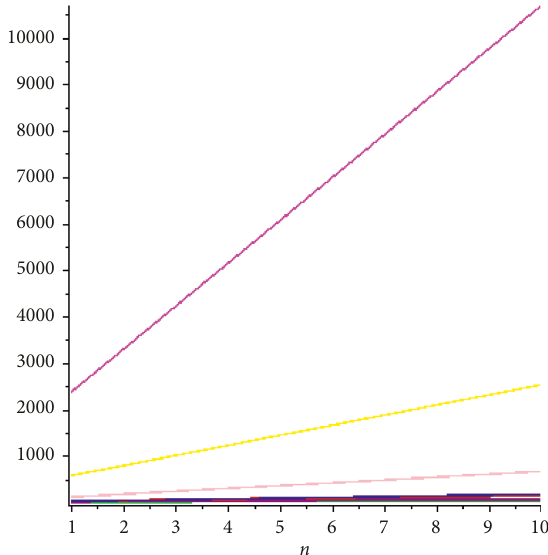
Figure 5: Graphical analysis of reverse degree-based topological